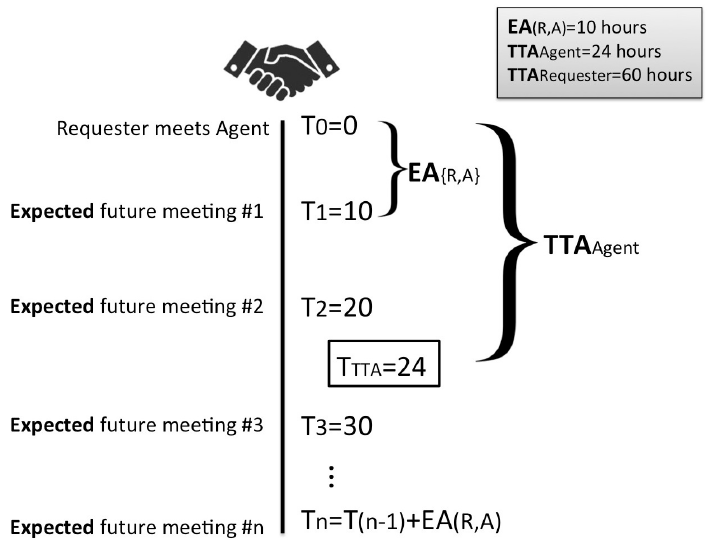
Figure 3. Calculation of DT Agent (Agent’s Delivery